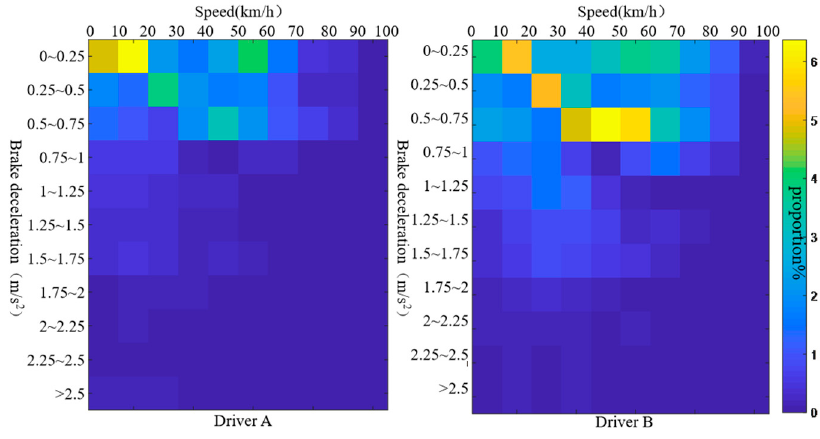
Figure 4. Joint distribution characteristics of vehicle speed and brake deceleration.